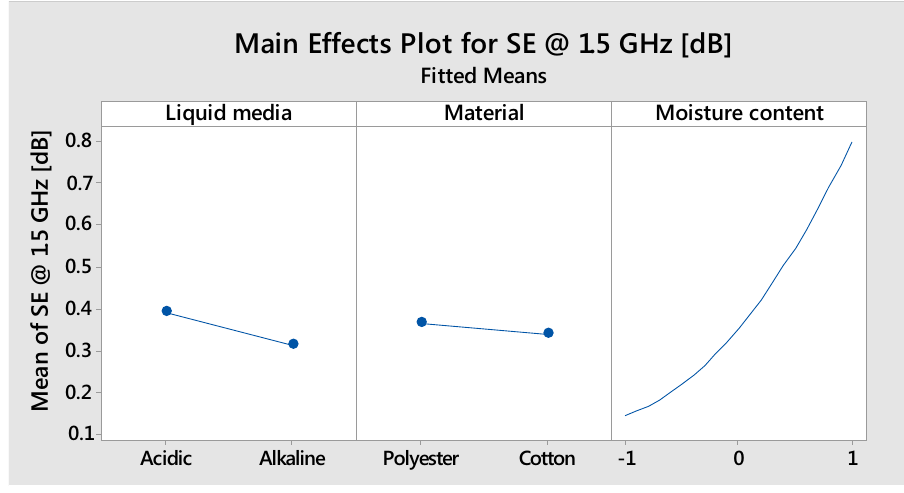
Figure 4. Main factors plot for SE at 1.5 GHz.